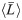
Average distance 〈L〉 the cargo travelled over a time interval Δ on the microtubule with a blocking filament located at distance l1 = 0.1 μm (curves with open symbols) and l1 = 0.5 μm (curves with filled symbols) from x = 0, Fig 3(b).The distance 〈L〉 was normalized by the average distance 〈L¯〉 the cargo travelled without the blocking filament. We used 3000 trajectories generated by the Markovian rate model (red squares) and the non-Markovian rate model (black circles) to calculate the average distances. Parameters of the models are the same as in Fig 4.